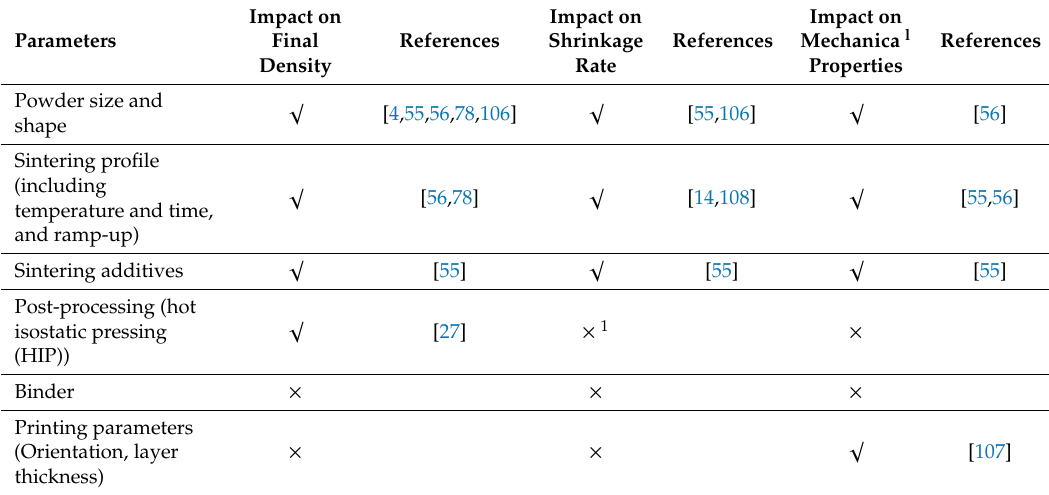
Table 3. Summary of BJ SS316L literature and factors have been investigated.